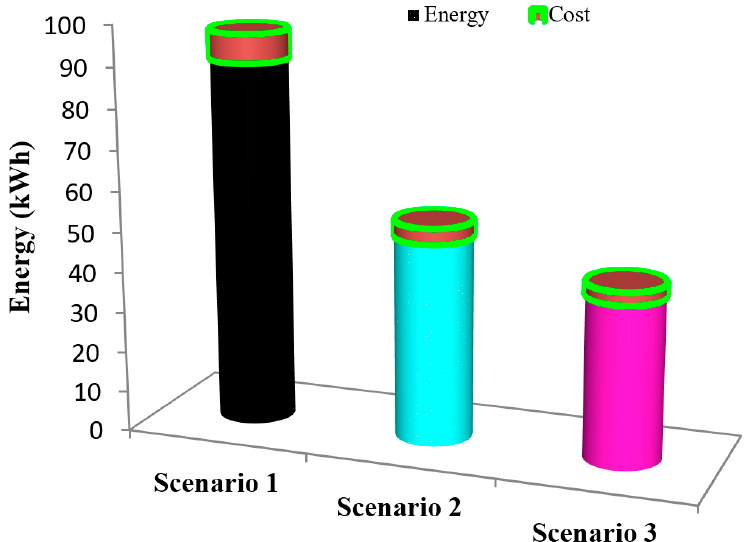
Figure 16. Comparison of the average daily energy and cost management for a single user within three scenarios.